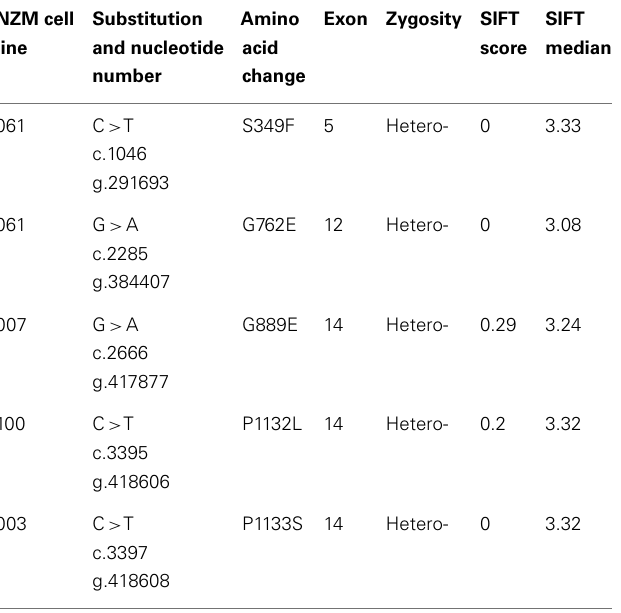
Table 3 | Non-synonymous mutations in GRIN2A . Table 4 | Synonymous mutations in GRIN2A .